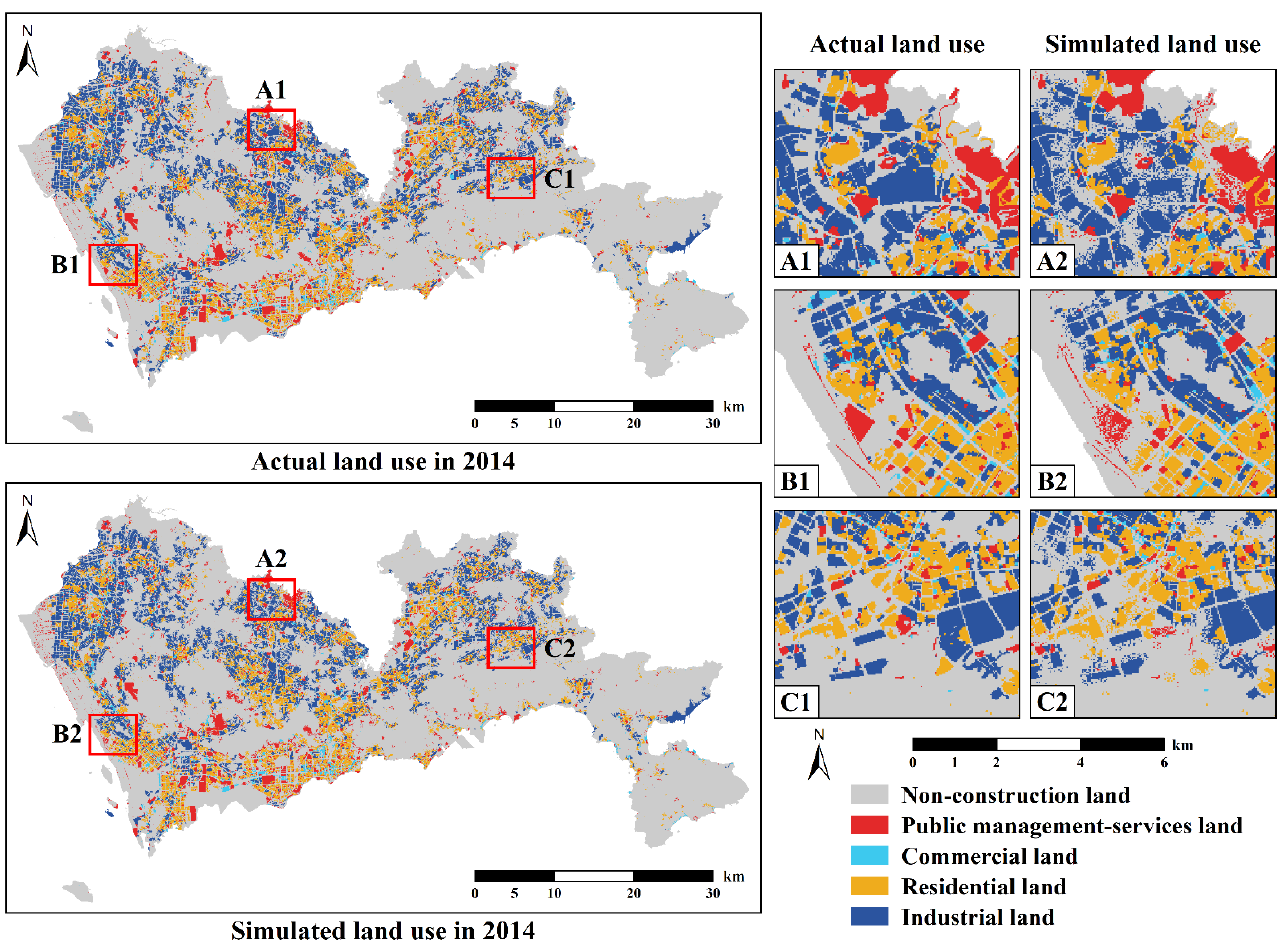
Figure 8. Actual and simulated land use patterns in Shenzhen in 2014. Where A, B, and C represent their respective regions, respectively; A1 and A2 represent the actual and simulated land use patterns in region A; B1 and B2 represent the actual and simulated land use patterns in region B; C1 and C2 represent the actual and simulated land use patterns in region C.